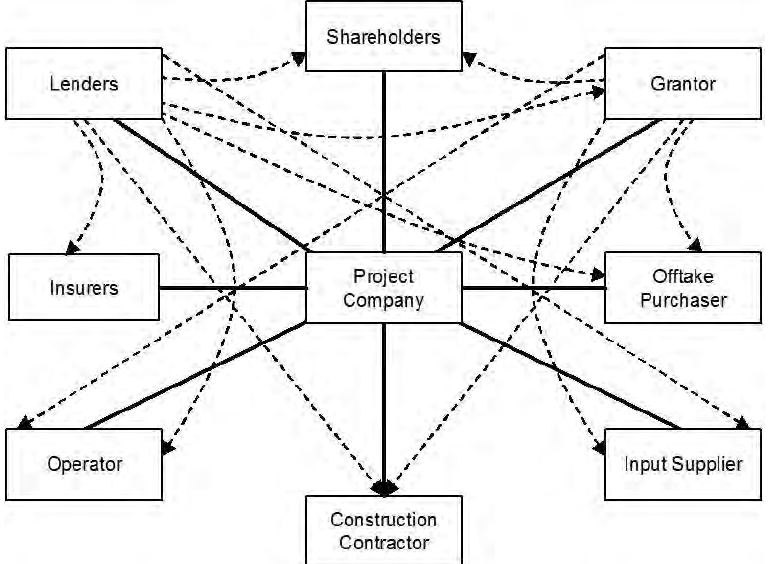
Figure 1. Typical Structure of PPP project (Neil Cuthbert,